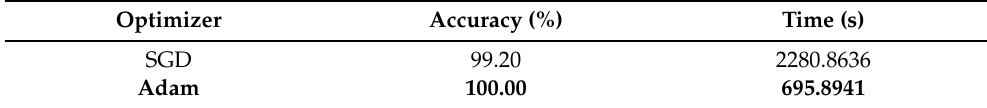
Table 7. Accuracy at different optimizers θ [ B = 32, P = 0.3, L = 0.0001].